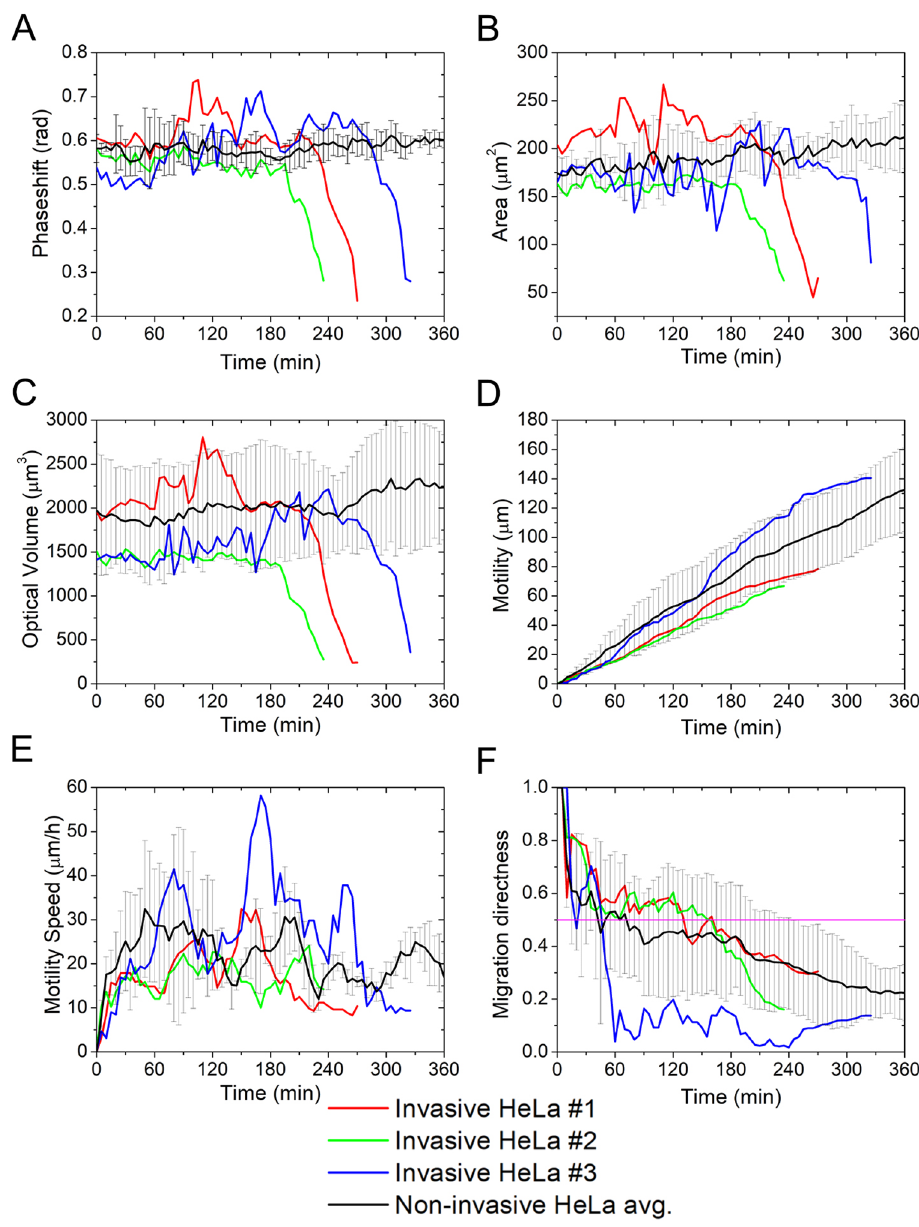
Figure 3. Phase shift ( A ), area ( B ), optical volume ( C ), motility ( D ), motility speed ( E ) and migration directness ( F ) of individual invasive (red, green, blue) and non-invasive HeLa cells. The black curve marks the average with the error marked with grey drop